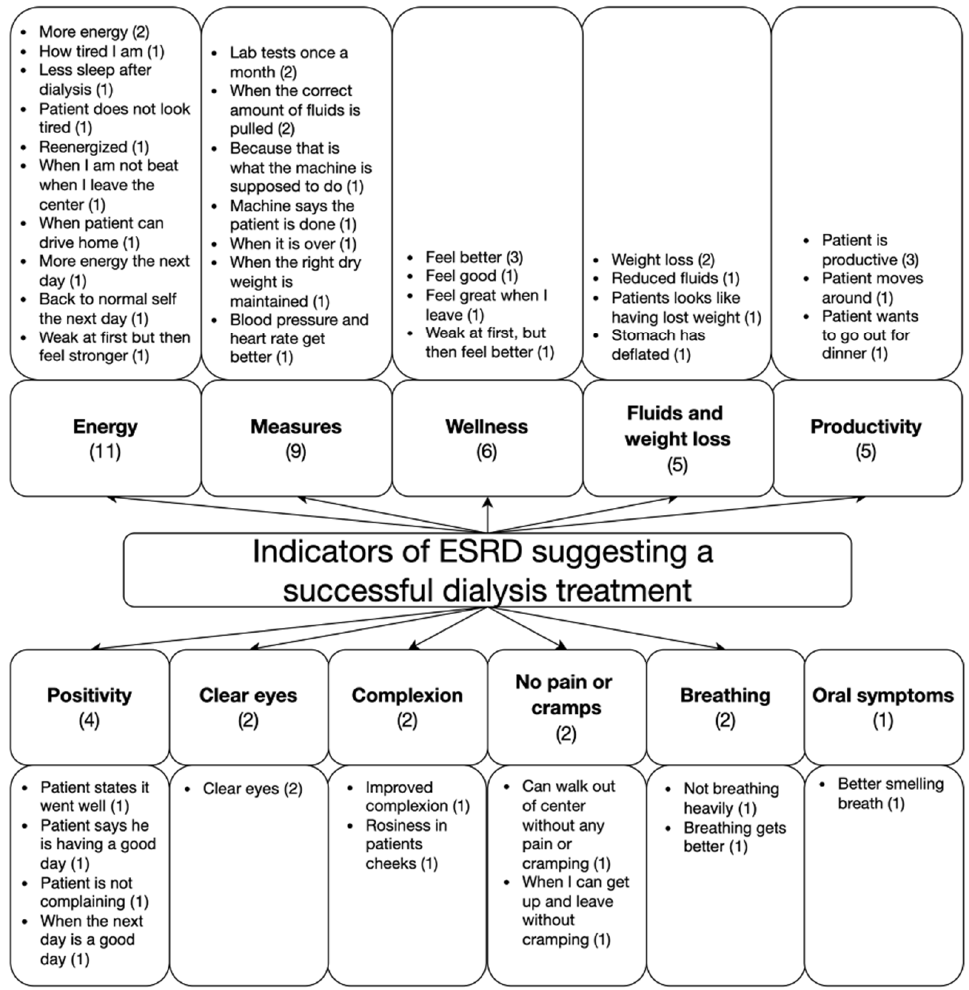
Figure 3. Categories and keywords related to patients’ and care partners’ awareness of indicators of ESRD suggesting a successful dialysis treatment. The number in parentheses next to each category indicates the number of times a related keyword or comment was mentioned by a participant.